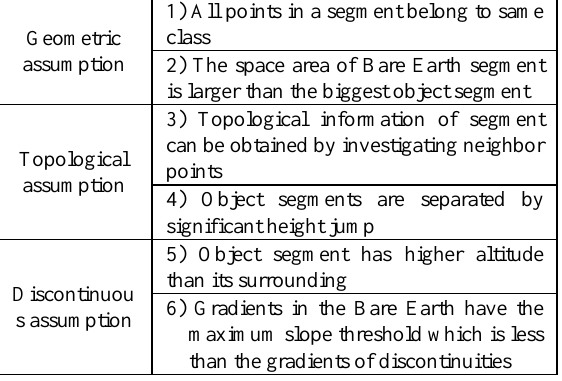
Table 1.The filter criterion base on the segments